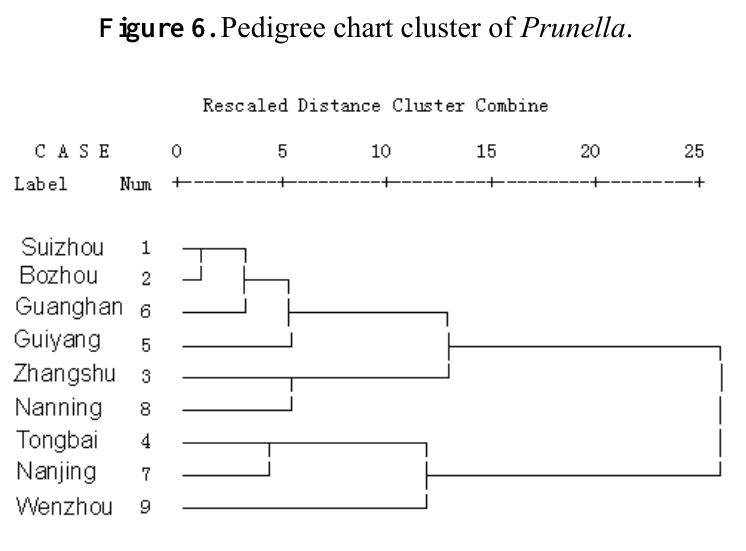
Figure 6. Pedigree chart cluster of Prunella